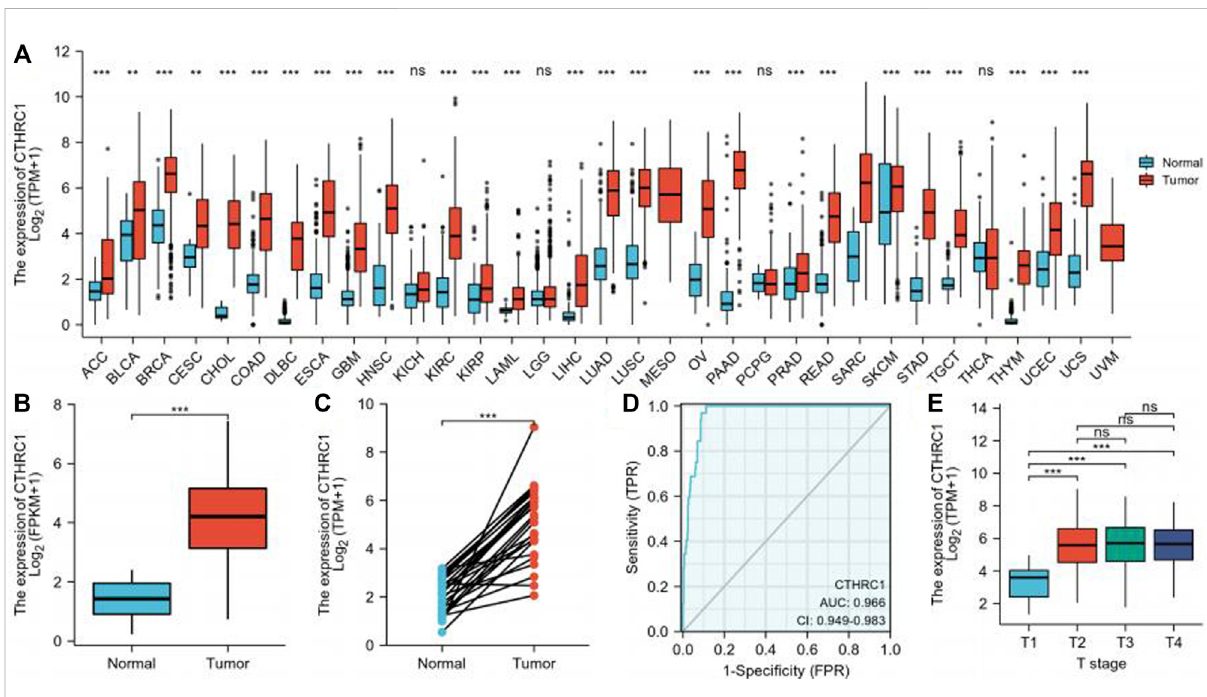
FIGURE 1 CTHRC1 Expression Levels in gastric cancer. (A) Higher or lower CTHRC1 expression in multiple tumors when compared with normal tissues across TCGA and the Genotype-Tissue Expression (GTEx). (B) CTHRC1 expression levels in gastric cancer and adjacent normal tissues across TCGA. (C) The expression of CTHRC1 in gastric cancer and its paired adjacent tissues. (D) Operating characteristic analysis (ROC) of CTHRC1 in gastric cancer. (E) CTHRC1 expression pattern by different T stage of gastric cancer. (* p < 0.05, ** p < 0.01, *** p <